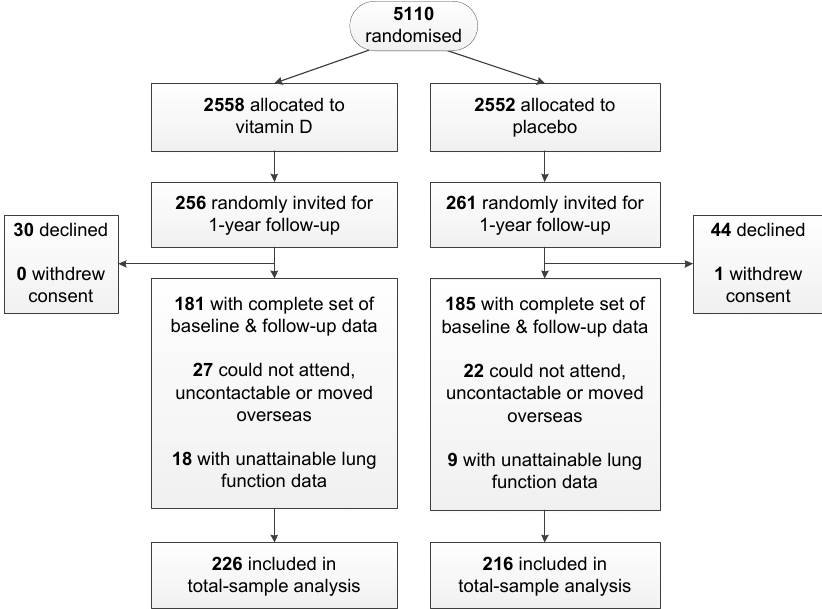
Figure 1. Flowchart showing the number of randomized participants who were excluded and those with a complete set of both baseline and 1-year follow-up measurements. Table 1. Baseline characteristics of all participants across treatment groups.